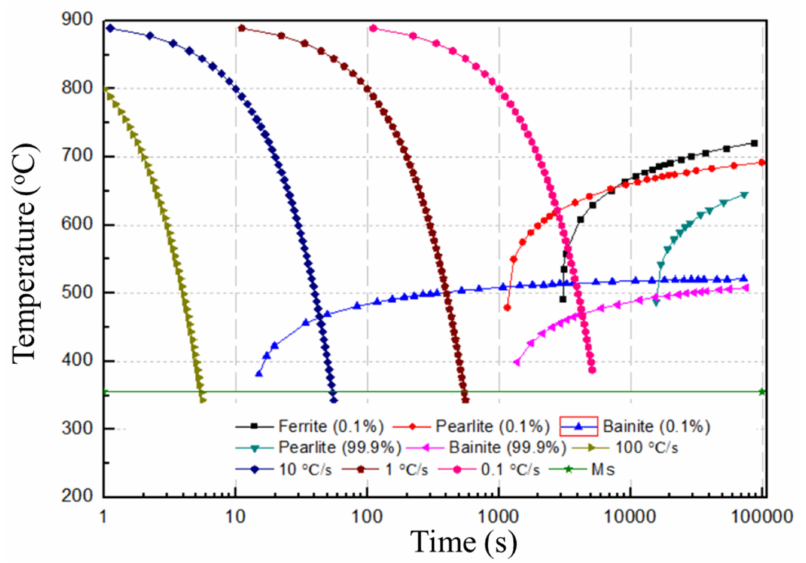
Figure 7. Continuous cooling transition (CCT) curve of low-alloy steel.